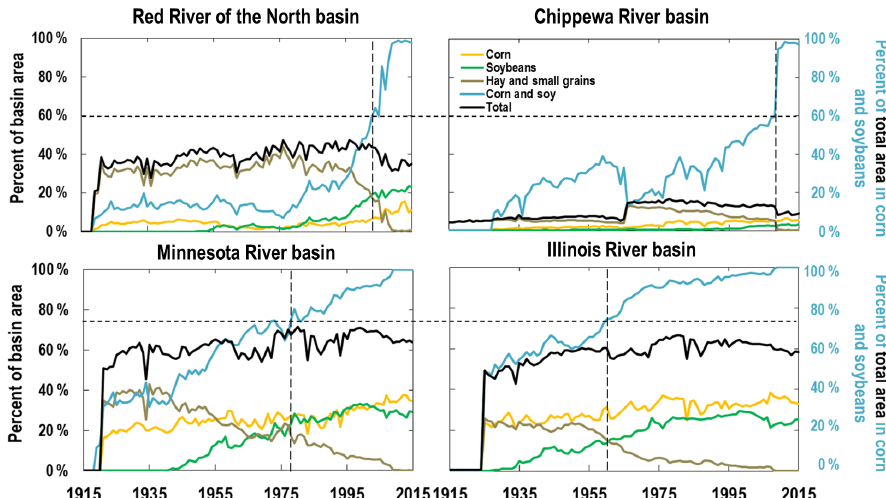
Figure 3. Acres harvested of corn, soybeans, and hay and small grains (barley, oats, wheat) expressed as percent watershed area for each of the basins based on county level data from USDA NASS. The sum of these three commodity groups is shown as a total in black and the percent of this total area in corn and soybeans is plotted in blue. Vertical dashed lines indicate when the percent of basin area harvested for soybeans exceeds hay and small grains. Horizontal dashed lines indicate when the percent of total area harvested for corn and soybeans exceeds 60% in the Red River of the North basin and Chippewa River basin and 75% in the Minnesota River basin and Illinois River